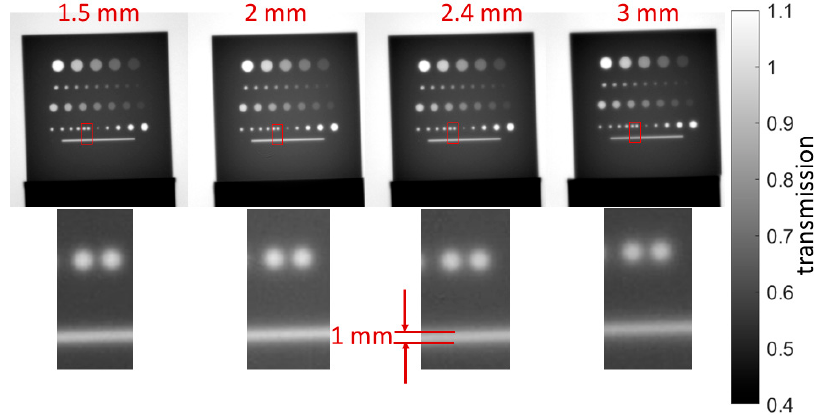
Figure 6. Test with resolution mask (5 cm steel block) for PP/ZnS:Cu scintillators.